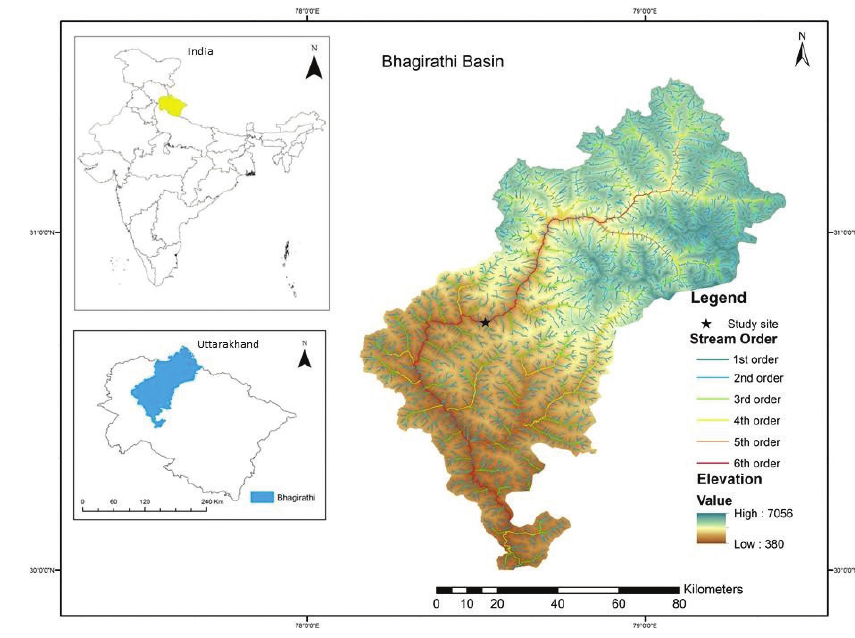
Figure 1. Map showing the study site location in Bhagirathi River Basin, Western